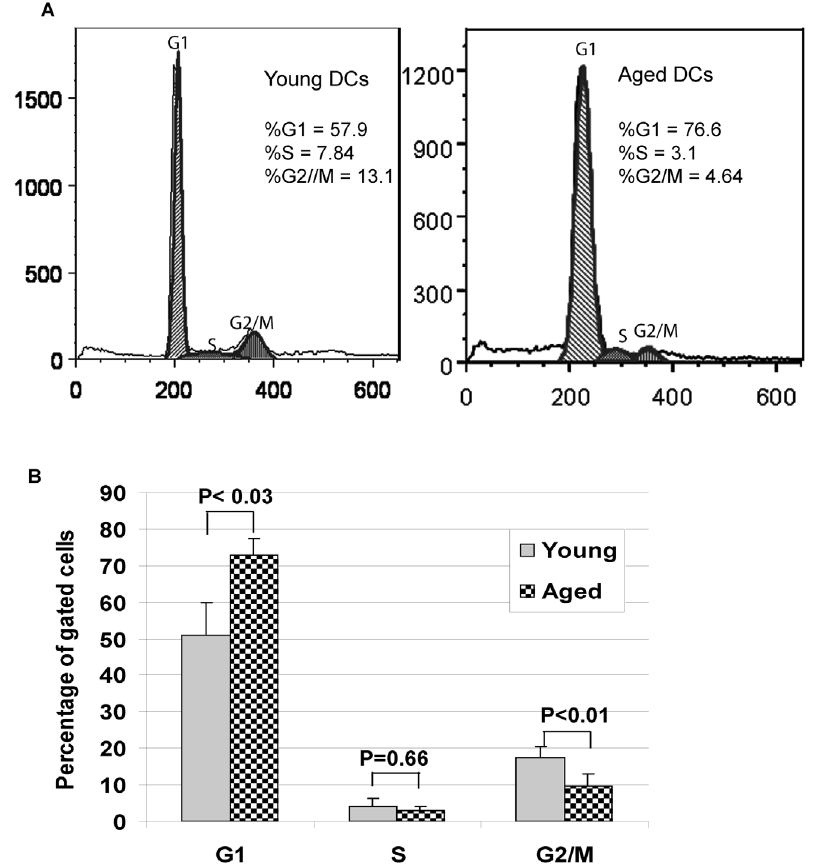
Figure 4. Cell cycle phases are different between MoDCs from aged and young donors. (A) Distribution of aged and young MoDCs existing in the various phases of the cell cycle as determined by FACS. (B) Statistical analysis and percentages of MoDCs from young and aged donors in each phase of the cell cycle (n=5, each group). Donors’ information sees Table 2.